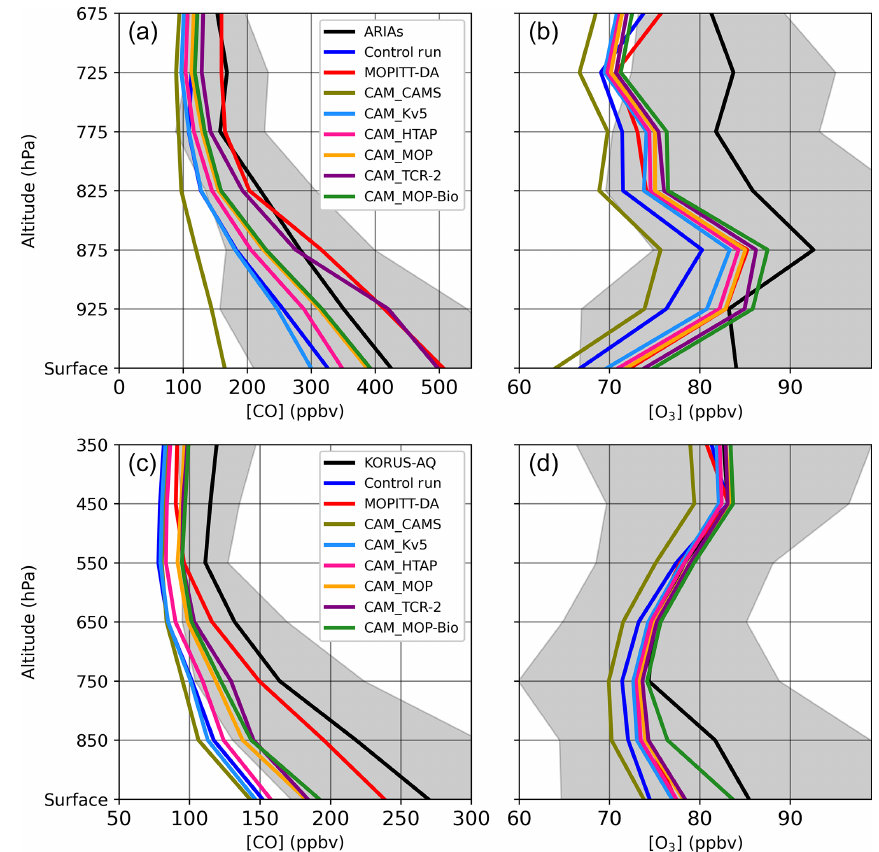
Figure 7. Average CO vertical profiles for the ARIAs campaign (a, b) and KORUS-AQ (c, d) . Observations were filtered out when SO 2 was higher than 20ppbv for ARIAs and benzene higher than 1ppbv for KORUS-AQ. The black line shows the observation mean, and the shaded area is the observation standard deviation. Only mean CO or O 3 are shown for the model simulations. Table 5. Comparison of O 3 measured aboard the DC-8 and model simulation for all altitudes. Statistical indicators are calculated for phase 2 (four flight days, 1910 observations), phase 3 (three flight days 1111 observations), and all of